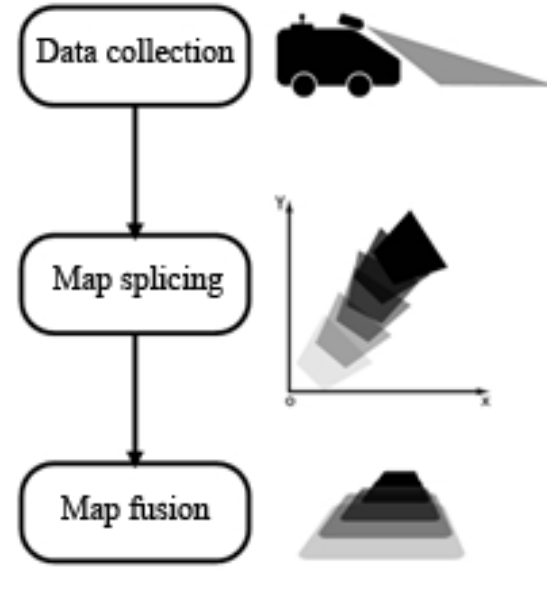
Fig. 1. System framework